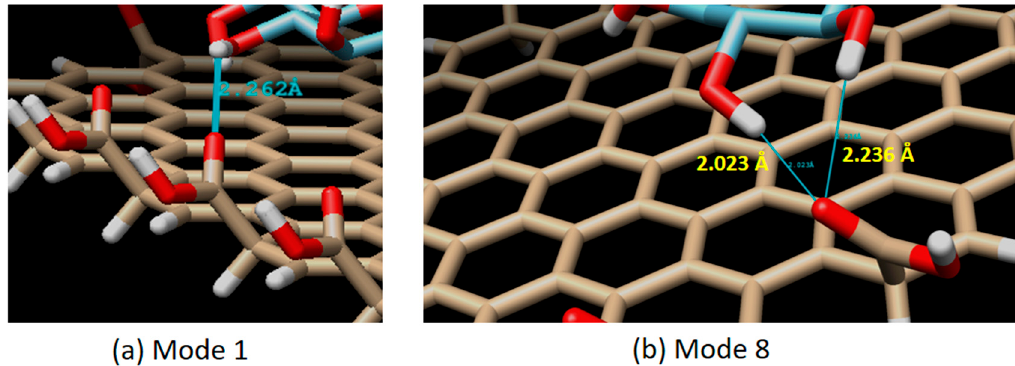
Figure 7. Interaction mode which has an H-bond. Single H-bond in mode 1 (H-bond distance of 2.262 Å), and a double H-bond in mode 8 (H-bond distance of 2.023 and 2.236 Å).